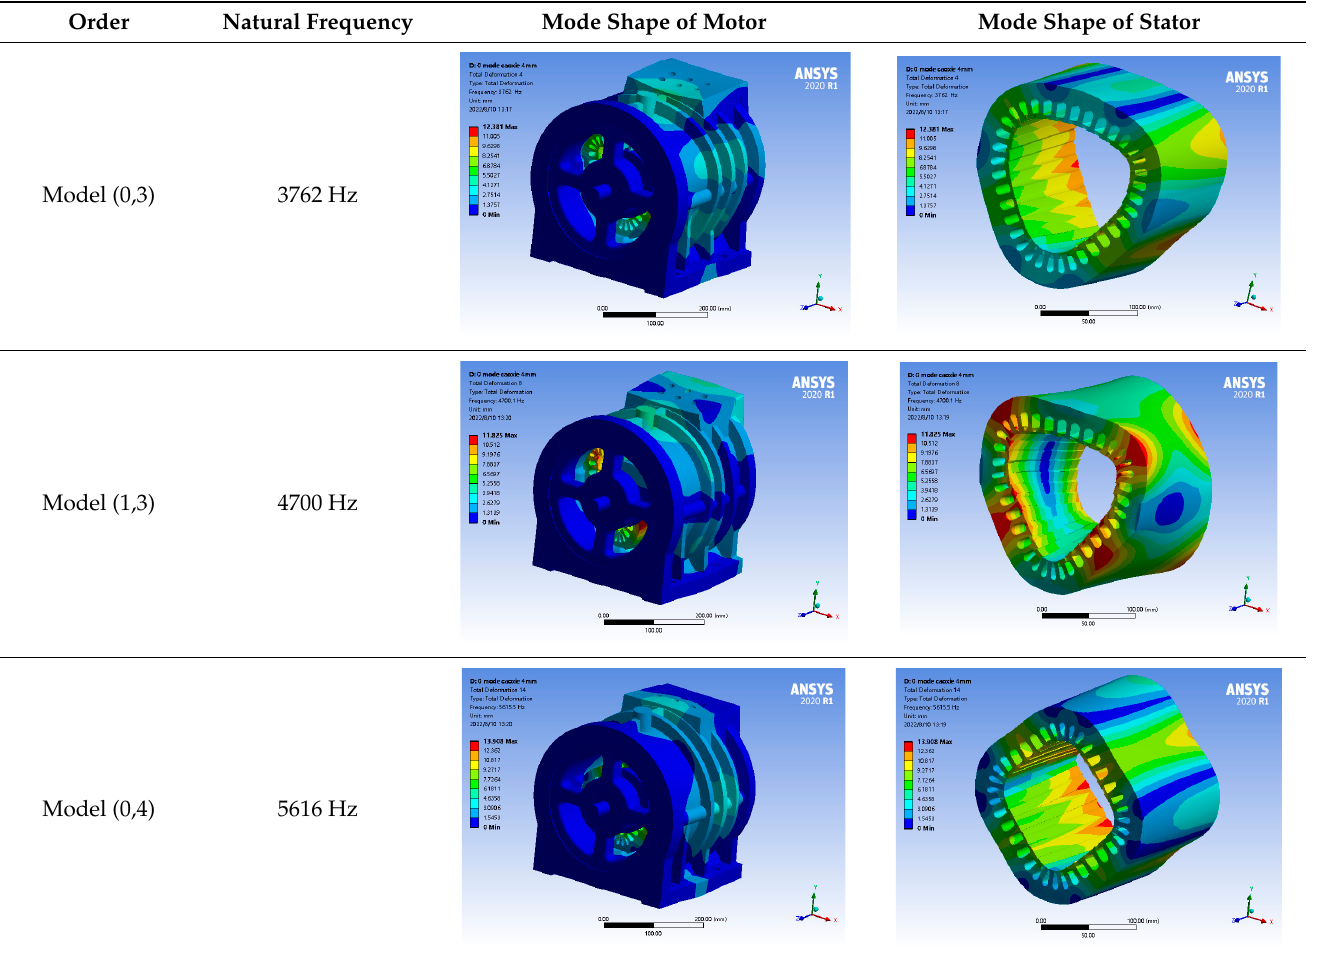
Table 4. Mode shapes and natural frequencies of main modes.